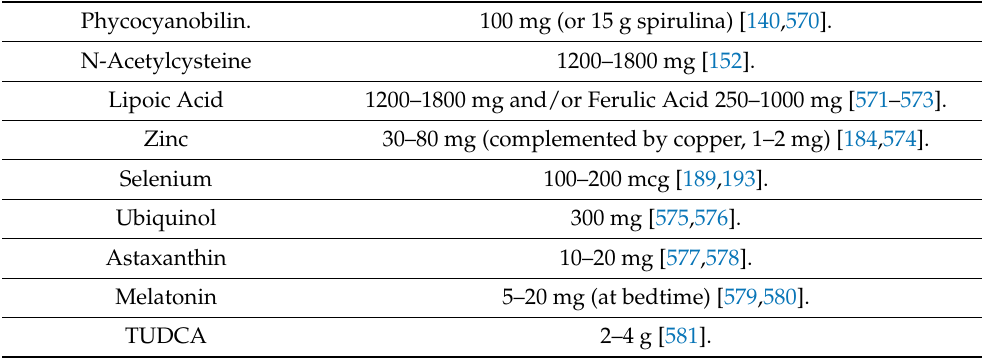
Table 1. Nutraceuticals for Prevention and Control of VH/HF—Suggested Daily Doses.